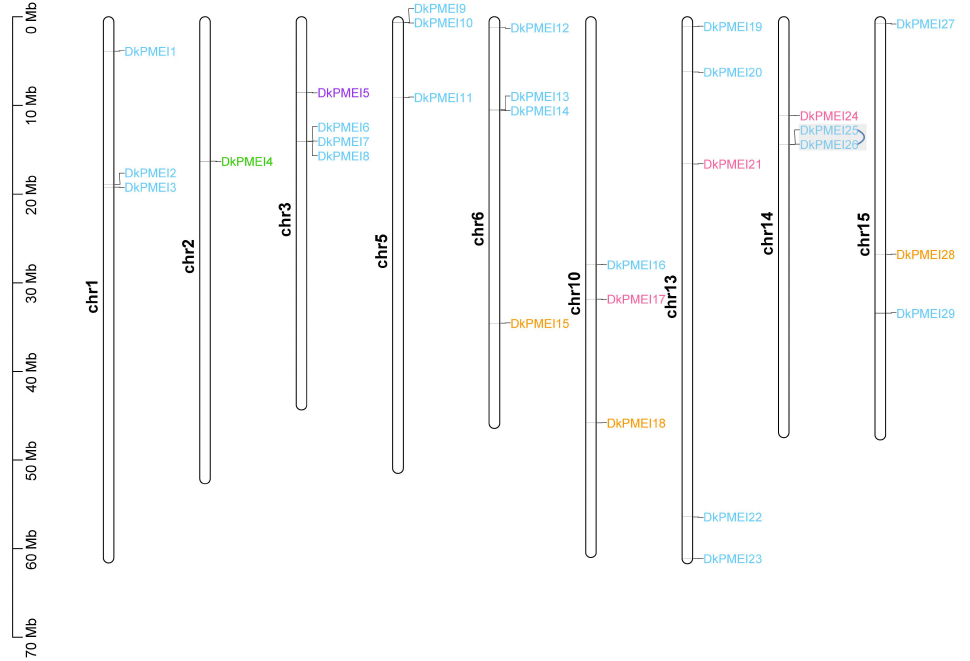
Figure 5. Chromosome location of DkPMEI genes in D. kaki. Genes of different groups are expressed in different colors. Gray boxes presented tandem duplication